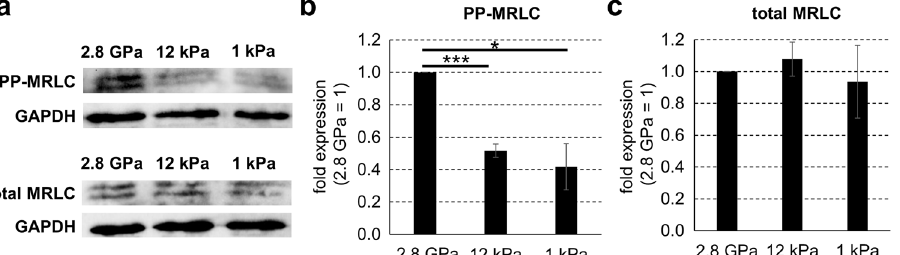
Figure 3. PP-MRLC of mouse embryonic neural stem cells is decreased by culturing on soft surfaces in the absence of serum. ( a ) Mouse embryonic NSCs were cultured on three types of plate (1 kPa plates, 12 kPa plates, and commonly used plastic plates [2.8 GPa]) for 3 days in serum-free condition. Protein expression of PP-MRLC, total MRLC, and GAPDH (for loading control) on each plate type was detected by western blotting analysis. The expression levels of ( b ) PP-MRLC and ( c ) total MRLC proteins were normalized relative to that of GAPDH protein. Error bars represent the standard deviation; * p < 0.05, *** p < 0.005 (Student’s t test with Bonferroni correction). NSCs neural stem cells, PP-MRLC di-phosphorylated myosin regulatory light